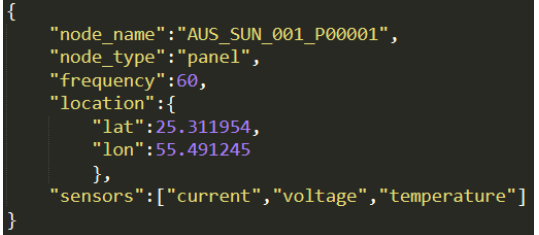
Figure 5. Panel monitoring edge device profile.